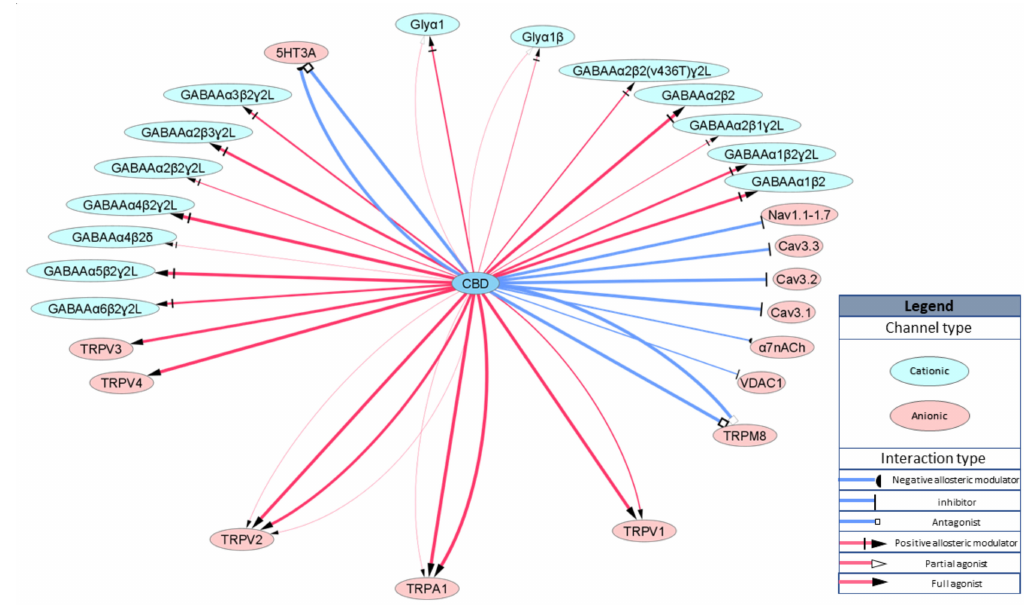
Figure 2. Schematic representation of CBD ionotropic targets. Width of the edges (lines) represents relative EC / IC50 ranging between 60 and 20,000 nM.